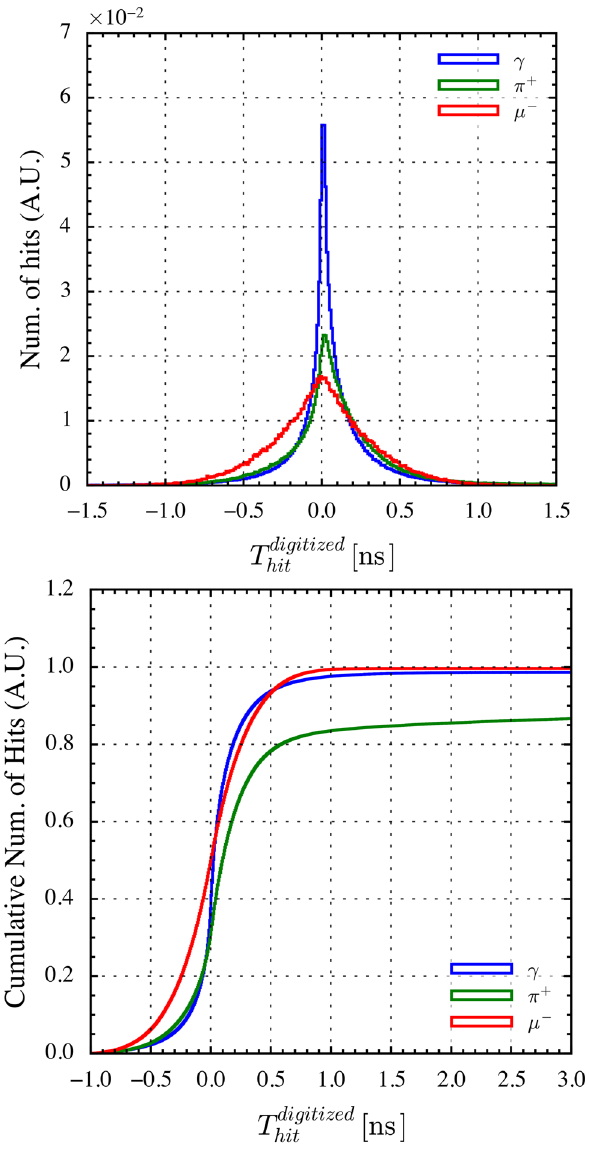
Fig. 7 The digitized hit time distribution in range of − 1 to 1 . 5 ns of 10 GeV γ , π + and μ − (top) and the cumulative distribution in the time range of − 1 to 3 ns (bottom), where the total number of all the hits